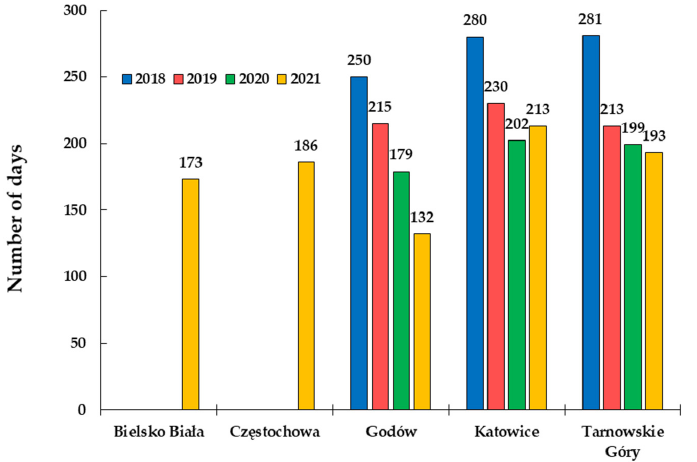
Figure 3. Number of days exceeding the values of the WHO-recommended daily mean concentrations of PM2.5. Due to the negative health effects of PM2.5, the ratio between the mass concentrations of PM2.5 and PM10, i.e., PM2.5/PM10, was additionally calculated (Table 1). For the entire calendar year, the PM2.5/PM10 ratio ranged from 0.6533 to 0.8804. In the heating and the non-heating seasons, the PM2.5/PM10 ratios were very similar, ranging from 0.6573 to 0.9877 and from 0.6451 to 0.7557, respectively, and they are similar to those in